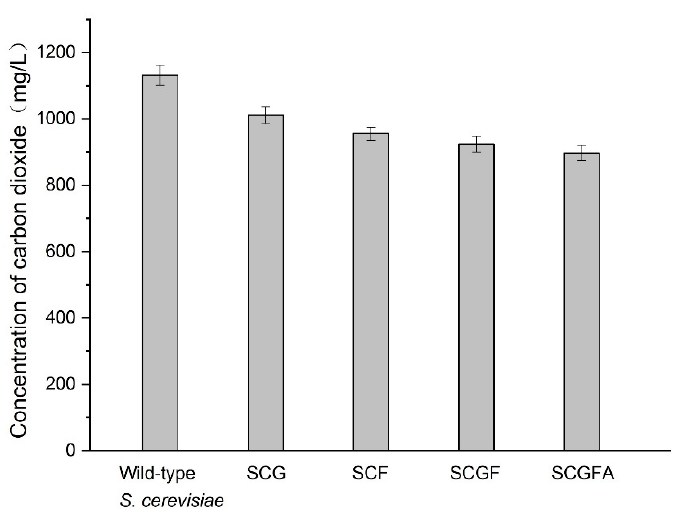
Figure 10. Comparison of CO 2 concentrations between the wild-type and engineered S. cerevisiae strains.